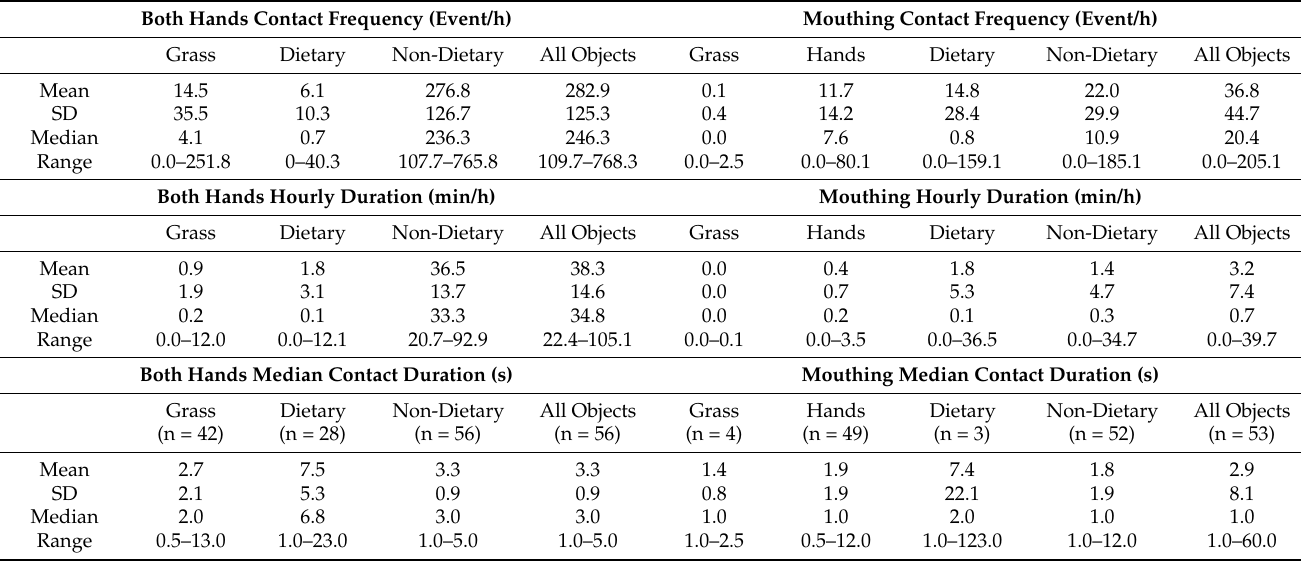
Table 3. Both hands and mouthing activity frequency, hourly duration, and median duration of children on turf (n =